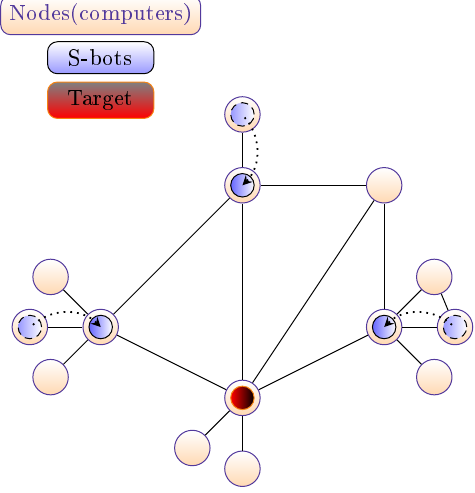
Fig. 3: Particles move in virtual network